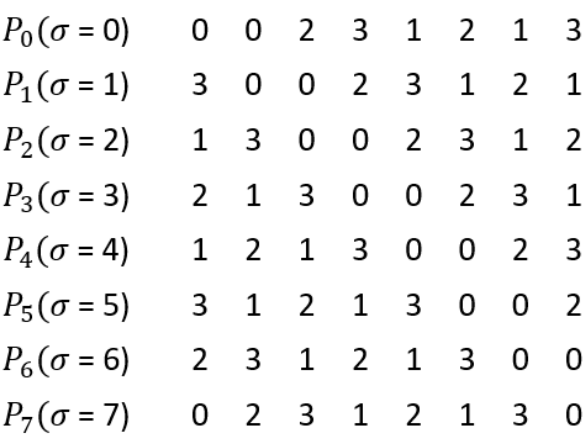
Figure 1. Different ELP